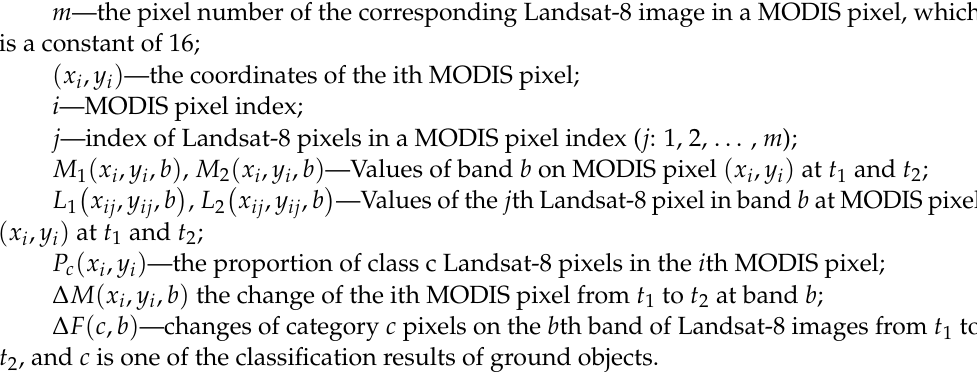
Figure 2. The algorithm flow.